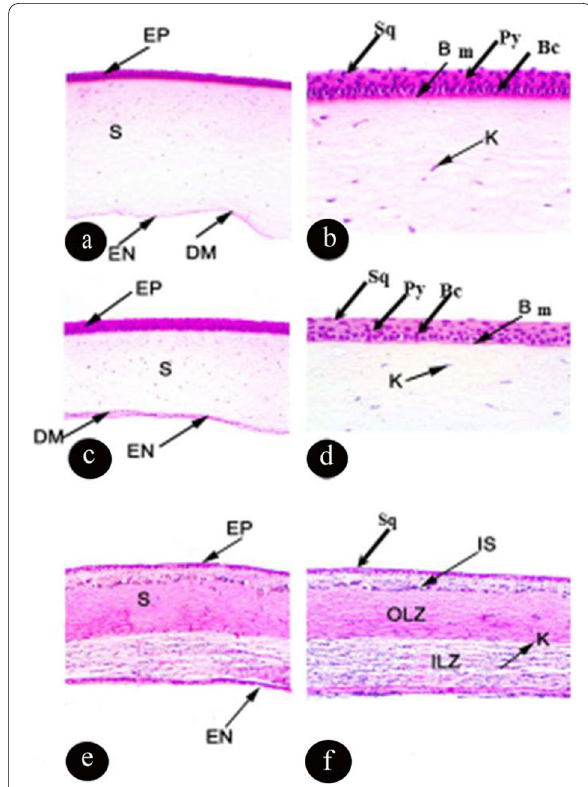
Fig. 2 Photomicrograph of transverse section of the cornea of Eudocimus albus ( a , b ) , Anas platyrhynchus ( c , d ) and Buteo buteo ( e , f ) showing PAS reaction in the corneal layers. a , c , e PAS X 100. b , d , f higher magnification (PAS X 400)